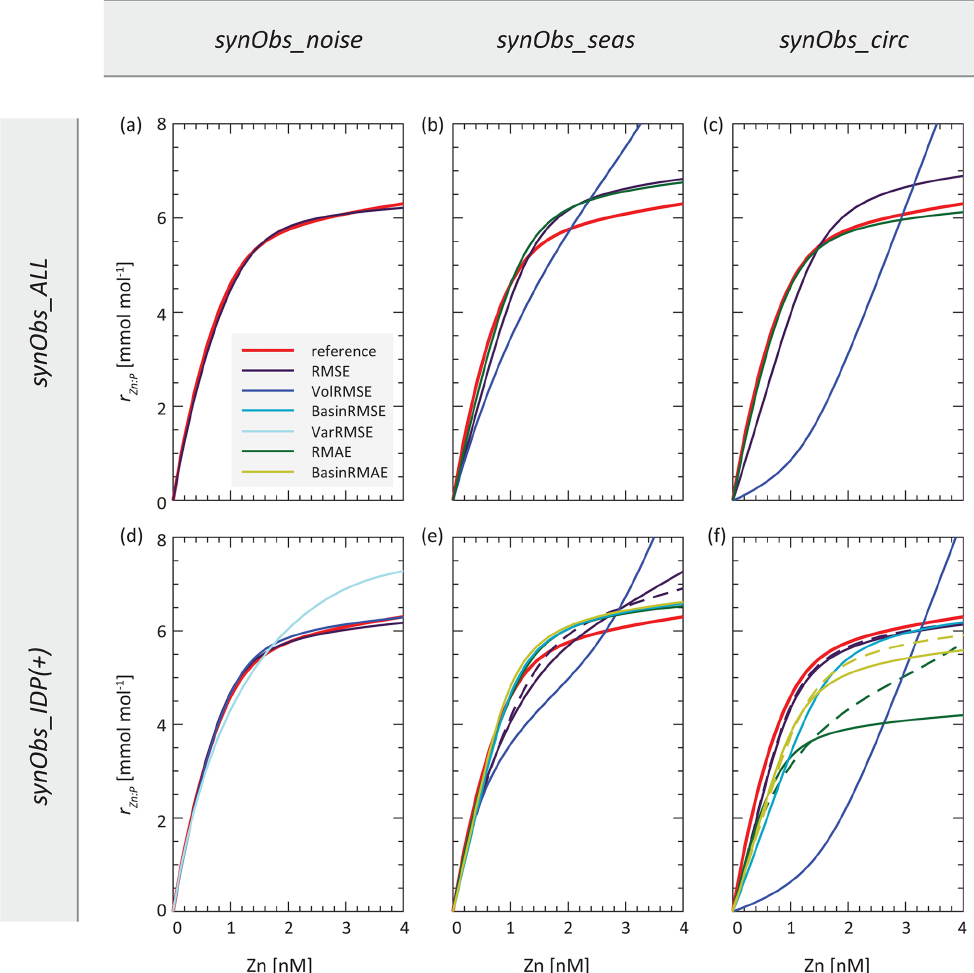
Figure 6. Zn uptake systematics resulting from optimised parameter sets obtained in synObs experiments. Dashed lines in panels (e) and (f) are results obtained with the IDP + data coverage (see